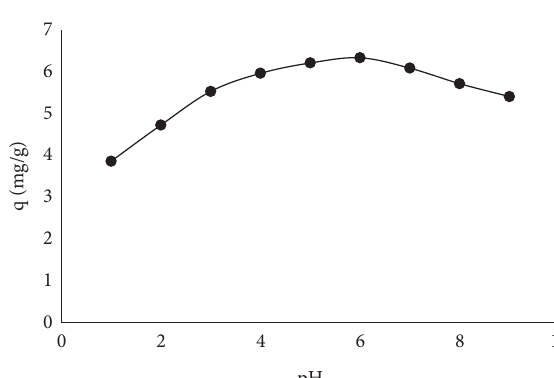
Figure 4: Influence of pH potency on GV removal.